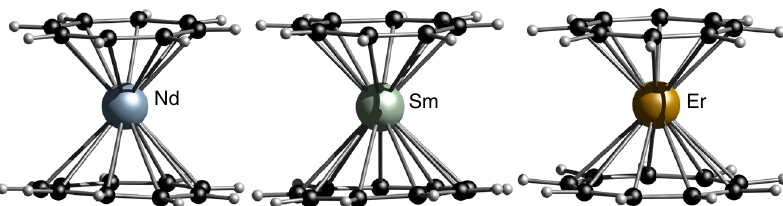
Fig. 5 Molecular structures of compounds 3a – d . [( η 9 -C 9 H 9 )Nd( η 8 -C 8 H 8 )] 3a (left) and [( η 9 -C 9 H 9 )Sm( η 8 -C 8 H 8 )] 3b (middle) in the solid state. Only on part of the disordered structures is depicted here. Geometry optimized structure of 3d (right). Color code: H, light; C, black; Nd, cyan; Sm, pale green; Er,